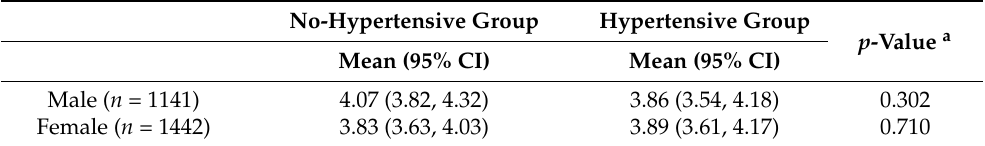
Table 2. Characteristics of hypertension and GDS according to sex.